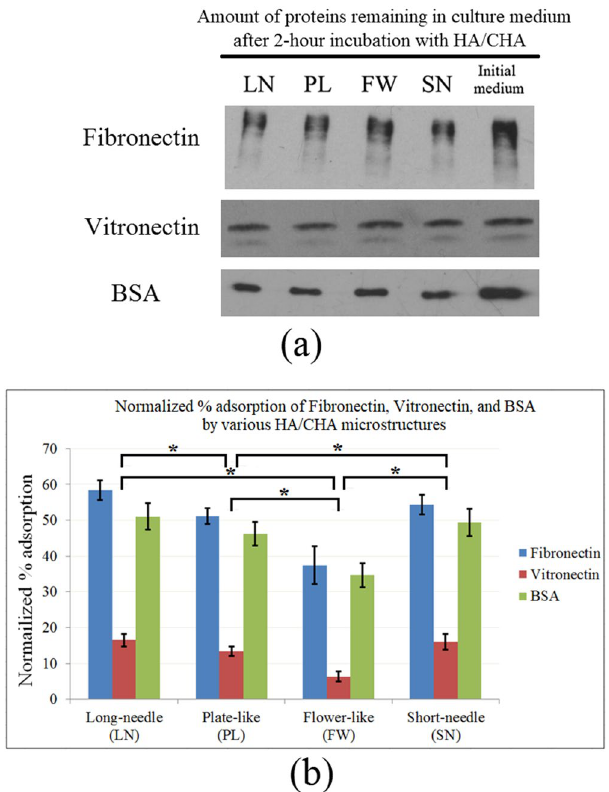
Figure 4. Quantitative analysis of proteins in culture medium adsorbed by HA/CHA. ( a ) Western blots of Fibronectin, Vitronectin, and BSA remaining in culture medium after a 2 h incubation period in the presence of HA/CHA-covered monoliths with four HA/CHA microstructures. ( b ) Average normalized % adsorption of Fibronectin (blue), Vitronectin (red), and BSA (green) on HA/CHA-covered monoliths with four HA/CHA microstructures. Significant differences in cell numbers are marked with *.